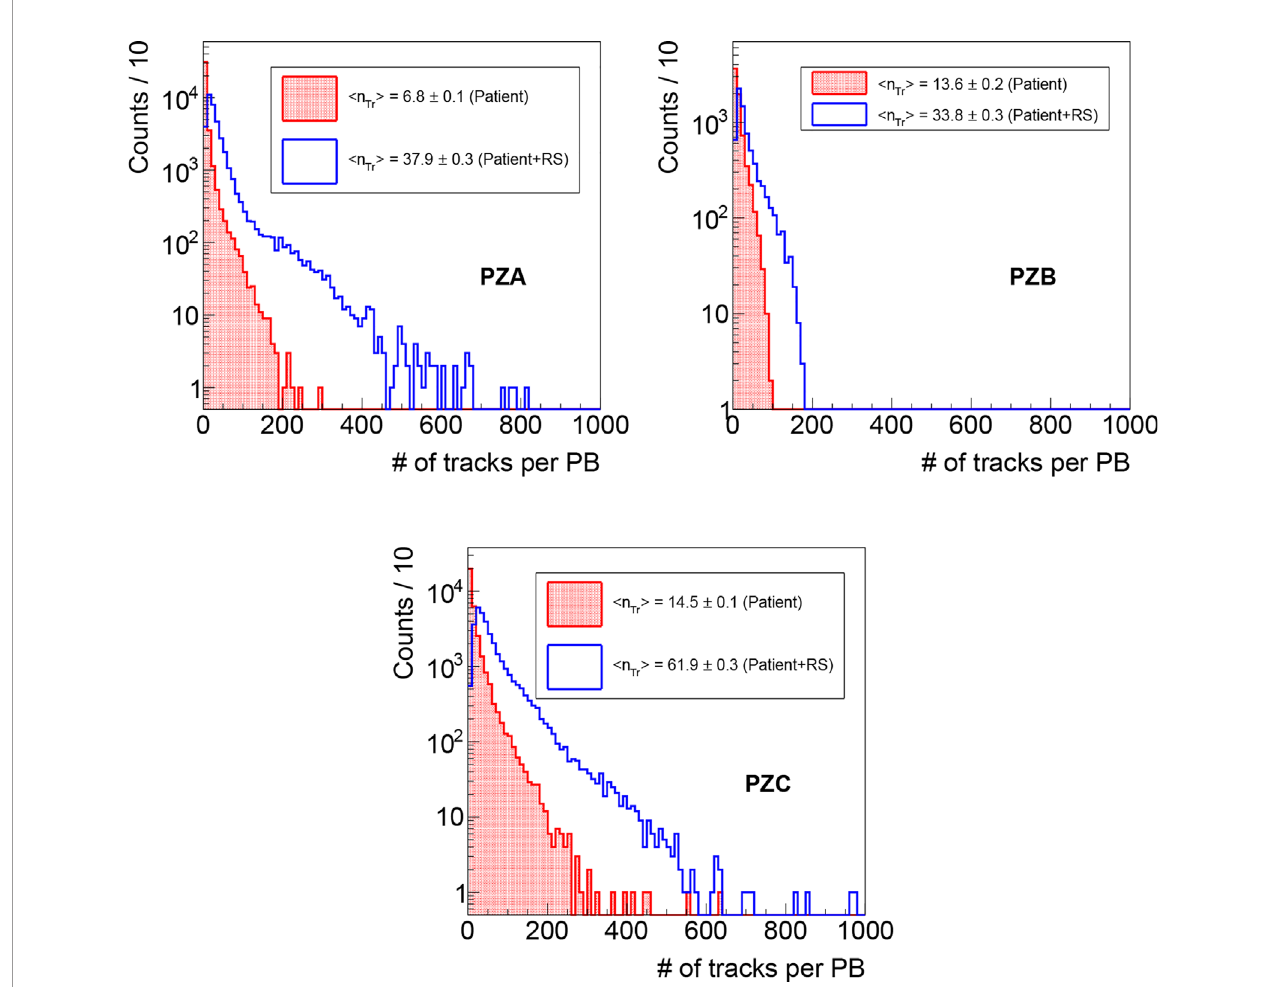
FIGURE 4 | Distributions of the number of reconstructed tracks per PB as measured during the fi rst fraction monitoring for PZA, PZB and PZC, obtained respectively selecting the fragments produced only in the patient (red line, dotted area), and that ones produced also in the RS (blue line, empty